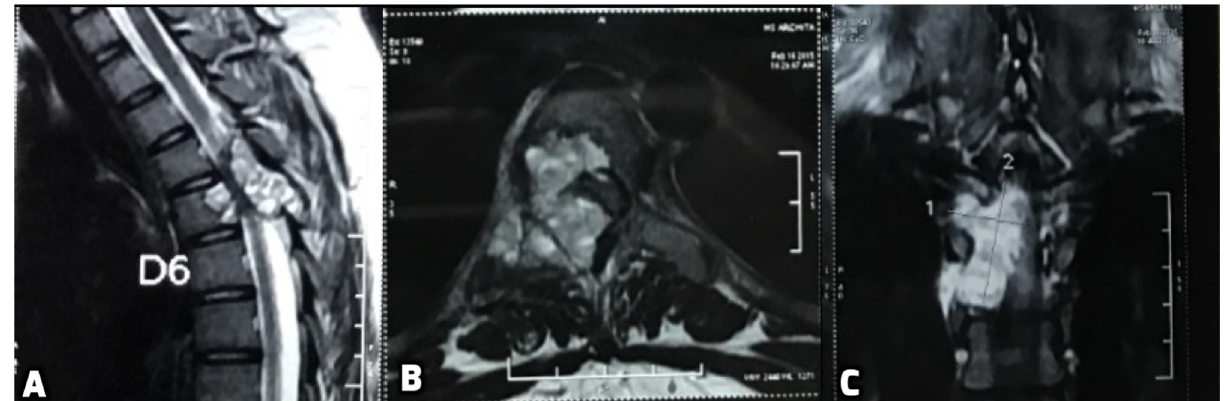
Figure 1. First Pre-operative MRI (A) revealing an intensely enhancing cystic cum haemorrhagic septate expansile bony lesion (5.7 (cid:1) 3.1 cm) involving the posterior part of D5 vertebral body, right lamina, right pedicle and transverse process with epidural extension (D4 – D5) causing marked spinal cord compression and underlying cord oedema. (B) Axial T2 MRI scan depicts the encroachment of the right half of body and posterior elements with compression of the spinal cord. (C) Coronal image through the spinal canal showing intense enhancement on T2 image with fl uid levels.